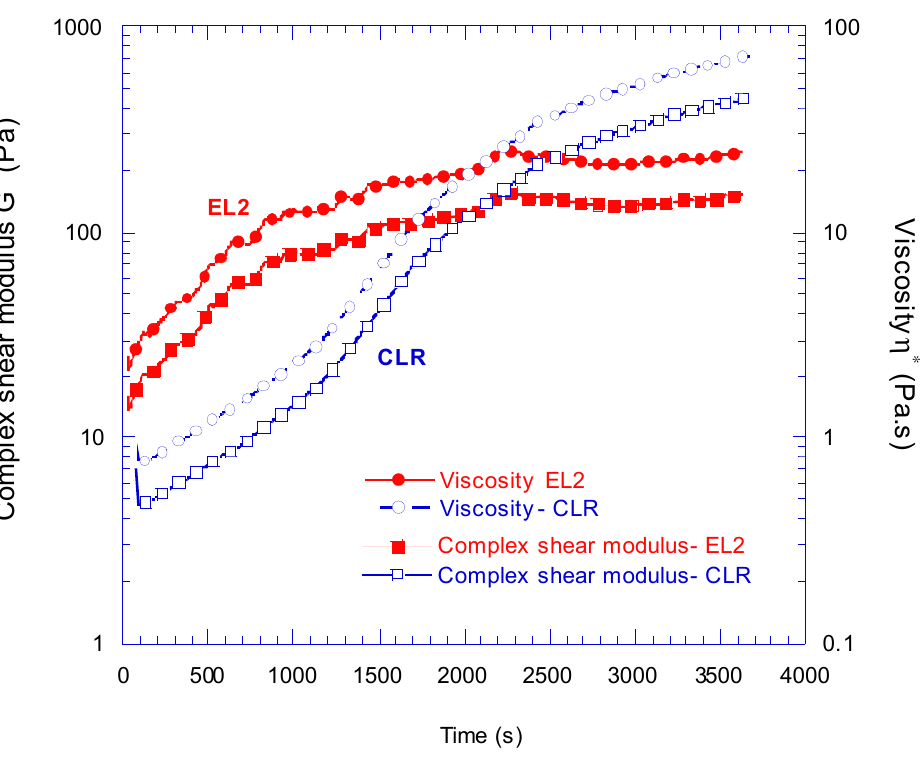
Figure 12. Variation of complex modulus ( G *) and complex viscosity ( η * ) of CLR bio-based and EL2 synthetic epoxies after 60 min of mixing with hardeners.